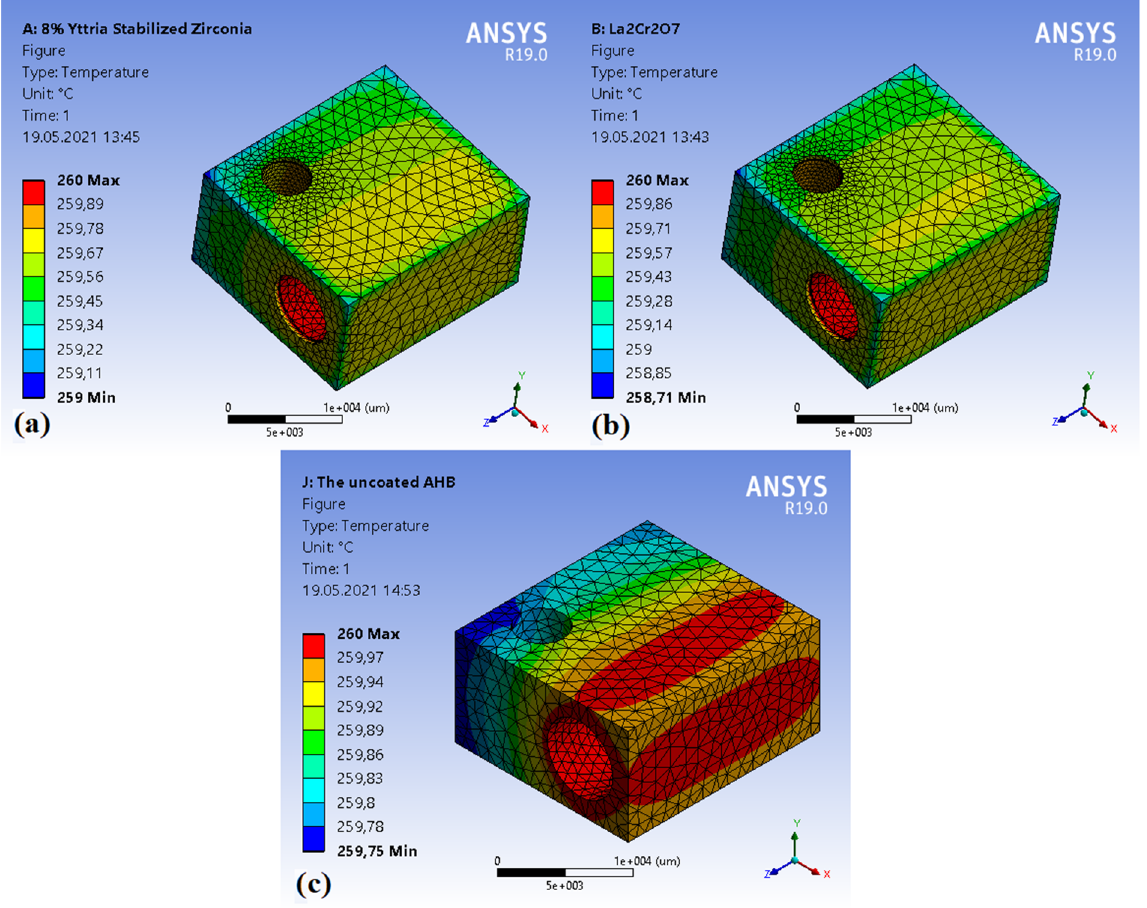
Figure 7. Temperature distribution of ( a ) YSZ-coated, ( b ) La 2 Cr 2 O 7 -coated, and ( c ) uncoated AHB.